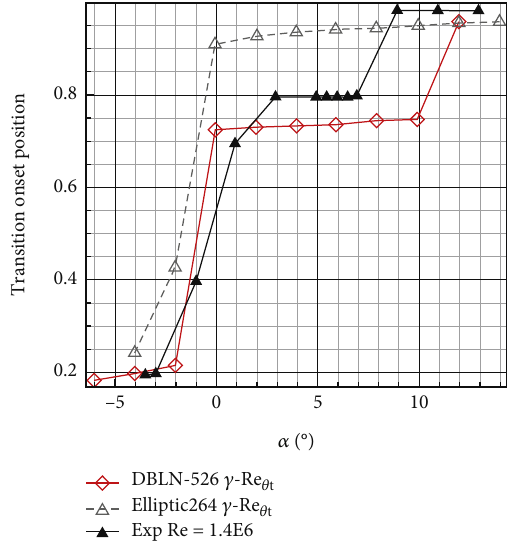
Figure 14: Pressure distribution ( Re = 1 : 4 E 6 . α = 6 ° ).